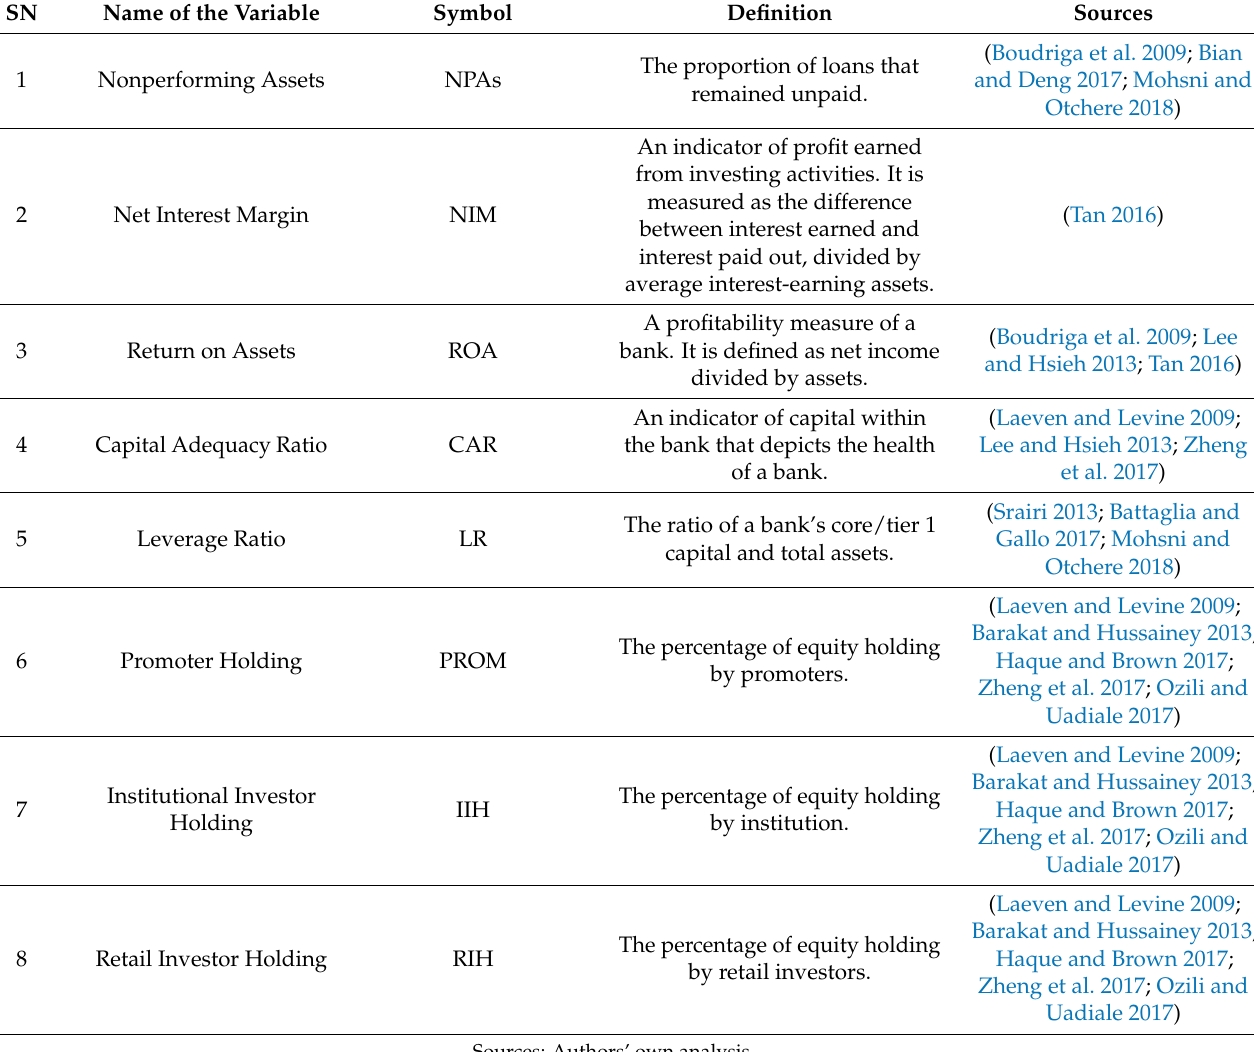
Table 1. List of